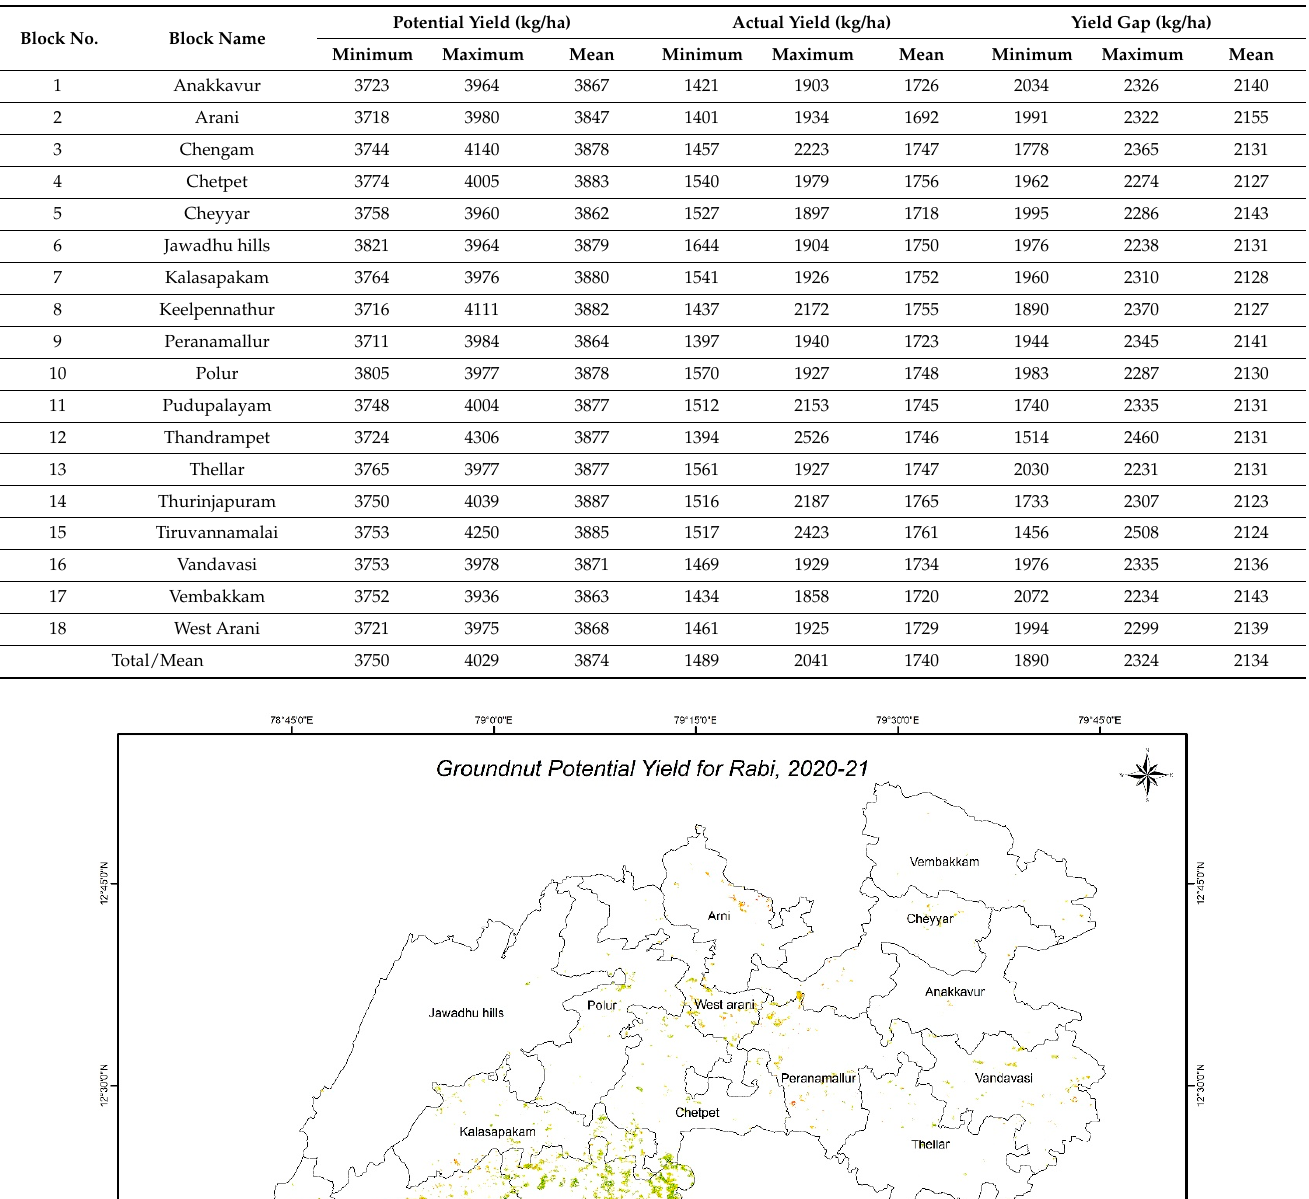
Table 6. Spatial variability of peanut potential yield, actual yield and yield gap estimated for the Tiruvannamalai district of Tamil Nadu during Rabi 2020–2021.